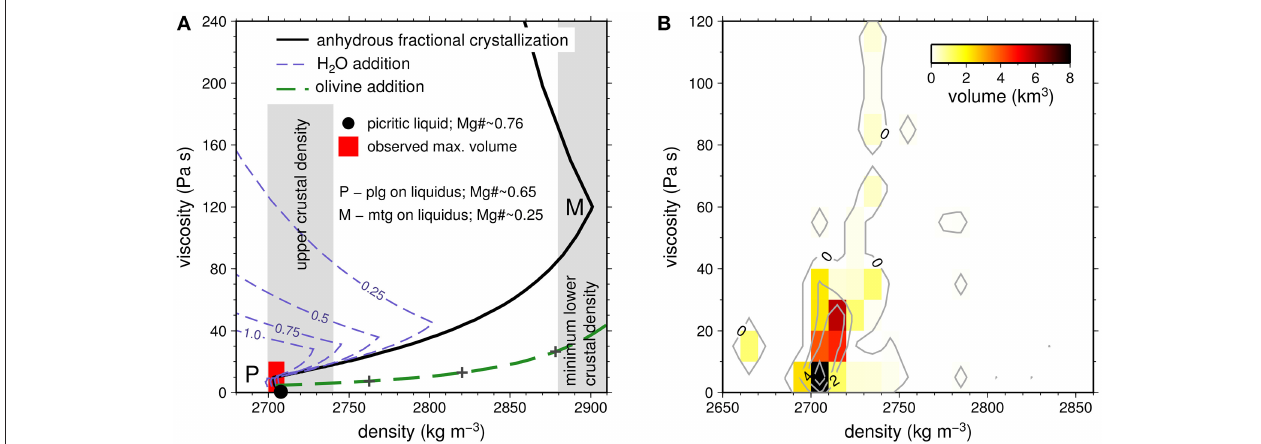
FIGURE 2 | (A) Fractional crystallization of a NVZ picrite with a whole-rock composition in equilibrium with Fo 90 olivine. The crystallization model shown was calculated in Petrolog3 using a pressure of 0.4 GPa. The black solid line shows the density and viscosity evolution of the melt (i.e., residual liquid) assuming that it undergoes perfect fractional crystallization. The arrivals of plagioclase (P) and magnetite (M) on the liquidus are associated with shifts in the density evolution of the melt. Thin blue dashed lines show crystallization models for the same starting composition but under hydrous conditions, with the starting wt.% H 2 O labeled on each line. The thick green dashed line shows the effect of adding olivine crystals to the starting composition on the magmatic (i.e., liquid plus crystals) density and viscosity; crosses show intervals of 10% olivine addition. (B) Relationship between magmatic density, viscosity, and erupted volume for postglacial lavas from Iceland’s NVZ. The cumulative lava volume in each box is colored according to the scale at the top and contoured in 2 km 3